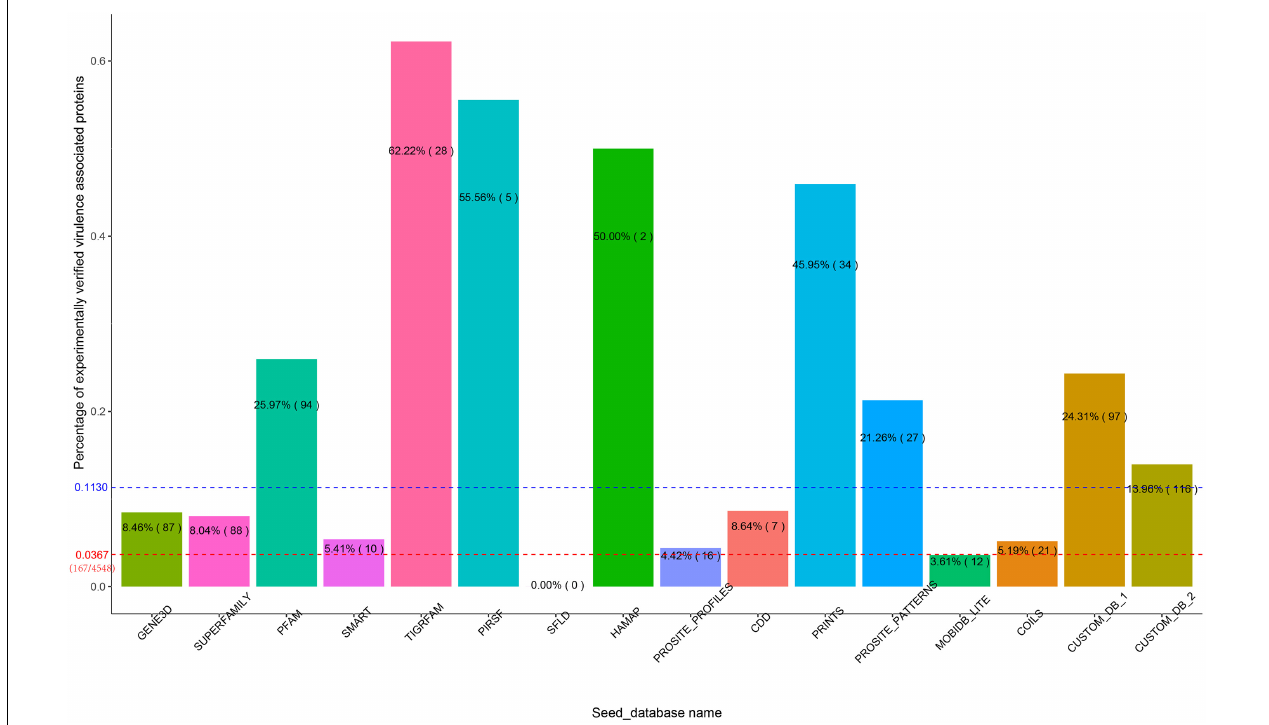
FIGURE 3 | Percent of experimentally verified S. Typhimurium virulence associated proteins among the predicted proteins with each Seed_database. The blue dotted line indicates the medium percentage among the Seed-database. For comparison, the red dotted line indicates the percentage of experimentally verified virulence proteins in S . Typhimurium out of all proteins encoded from this